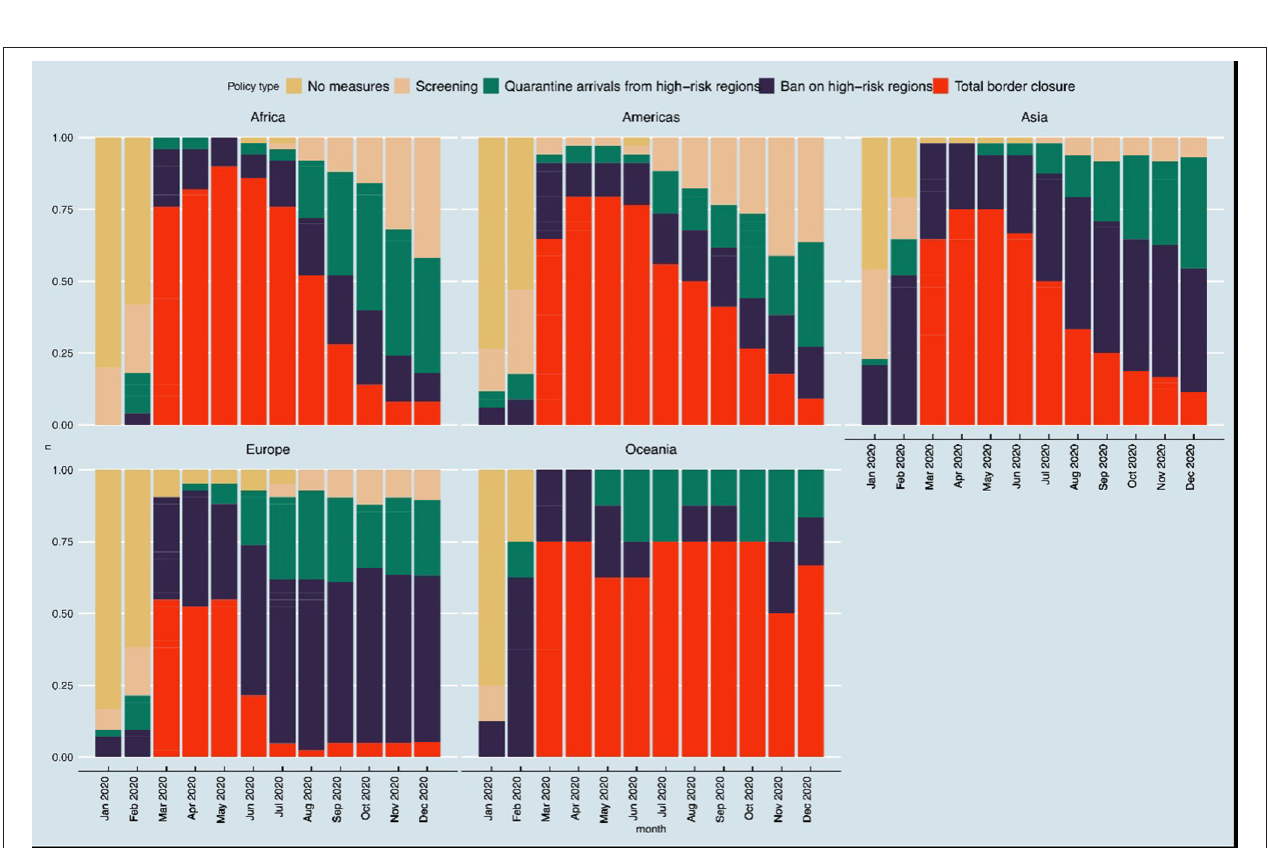
FIGURE 3 | World map of trends in restrictions on internal movement.